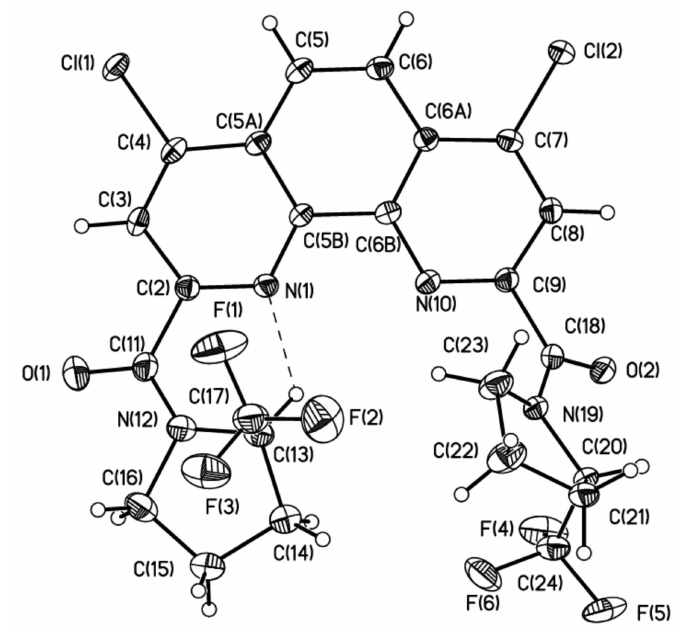
Figure 7. The general view of 2B in representation of atoms by thermal ellipsoids ( p =